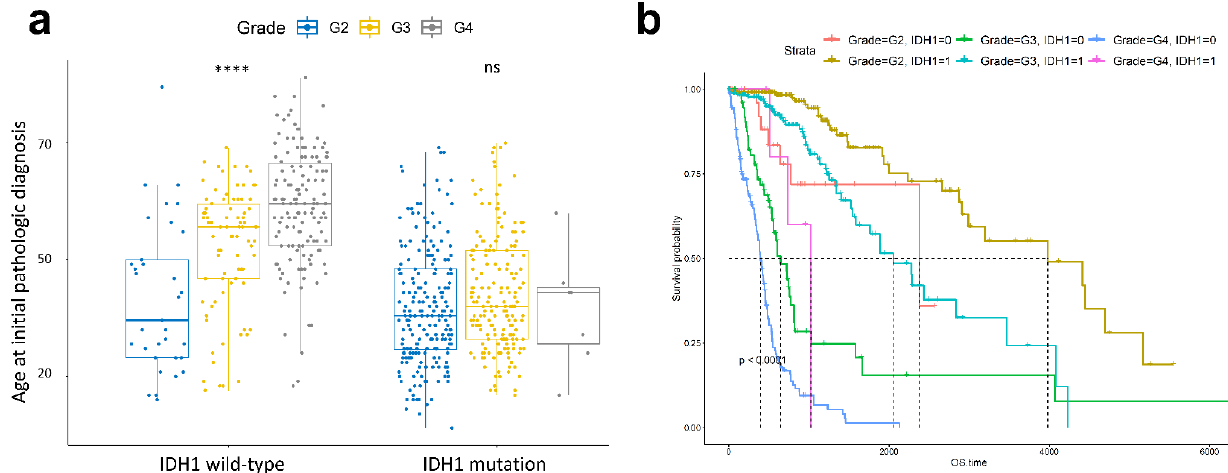
Figure 2. Comparison of tumour grades of patients with IDH1 wild-type and IDH1 mutation with respect to age at initial pathologic diagnosis. p -value <0.0001 are indicated by ****. ns is not significant ( a ). Survival analysis comparing patients with IDH1 wild-type or IDH1 mutation in each tumour grade. 0 indicates wild-type; 1 indicates mutation. Time up to which 50% patients survived is shown by the dotted line in every type. The unit of overall survival (OS) time is day ( b